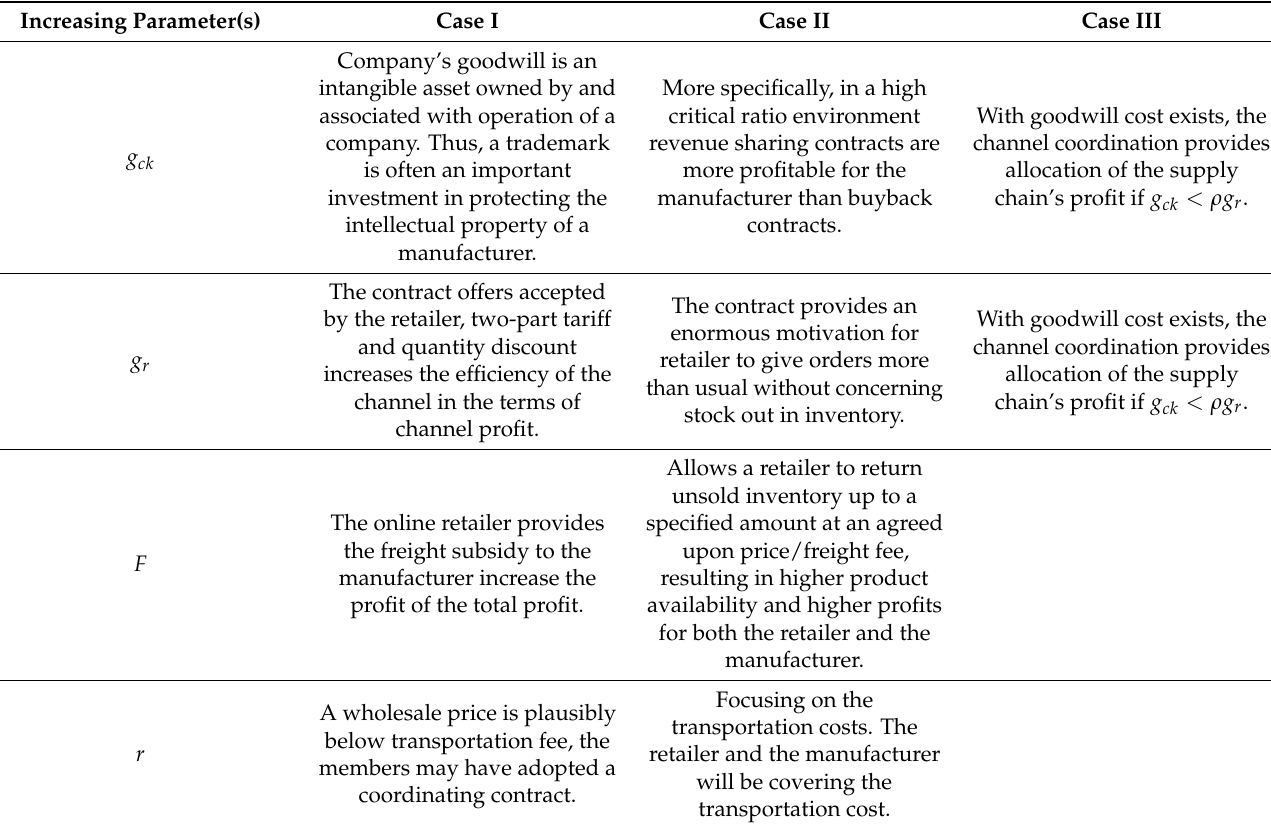
Table 5. Effect of changes in various parameters of managerial